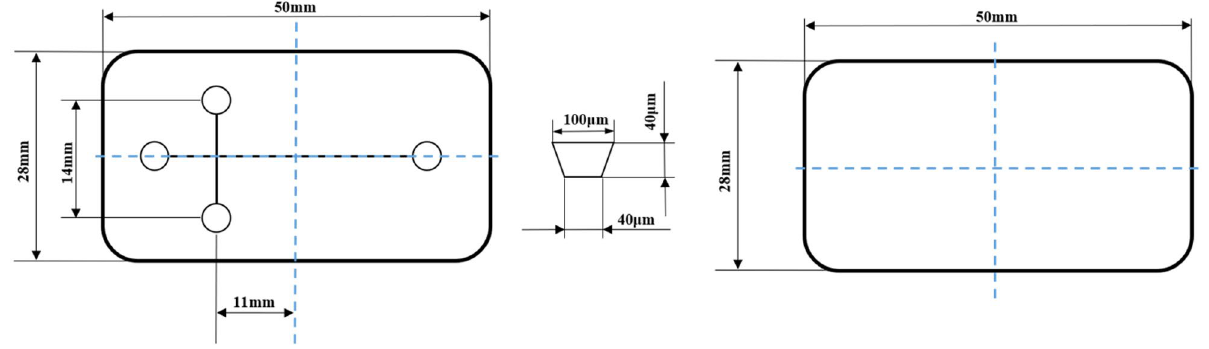
Figure 1. The detailed structure and size of protein electrophoresis microfluidic chip.